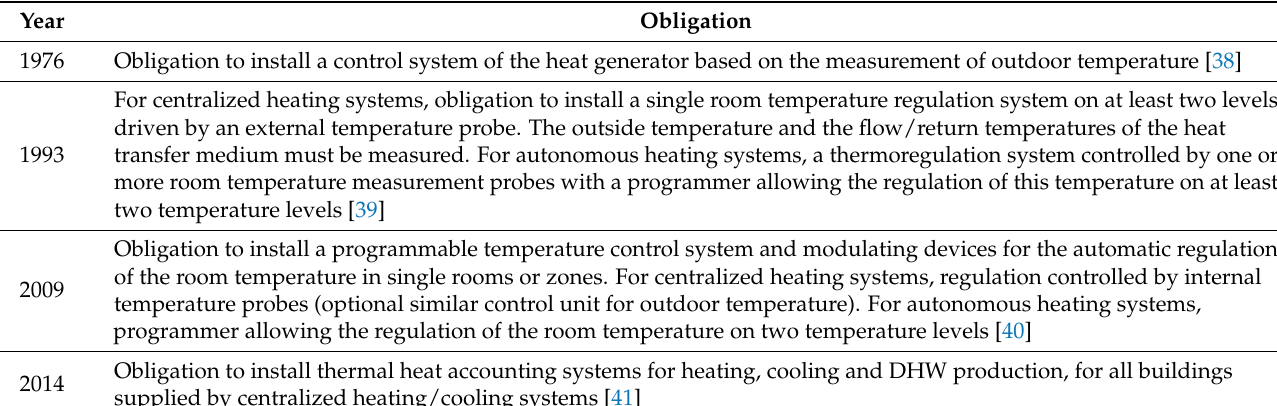
Table 1. Legislative references for heating plants in residential buildings.